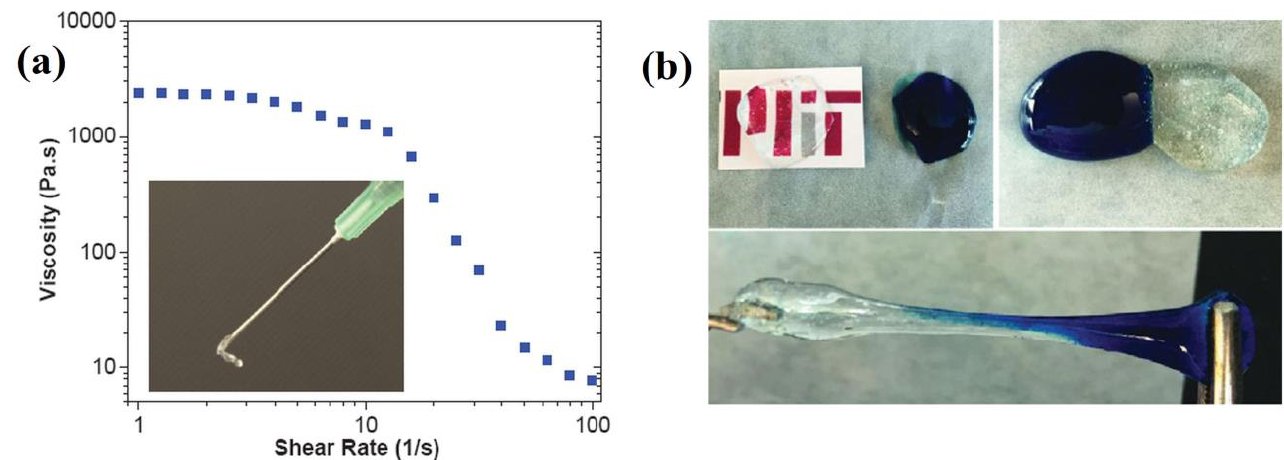
Figure 17. ( a ) Shear-thinning behavior and ( b ) exemplification of the self-healing property of the gel based on PEG and 3-fluorophenylboronic acid formed at pH = 7 (Reproduced with permission from [106]. Copyright © 2023 WILEY-VCH Verlag GmbH & Co. KGaA, Weinheim) .